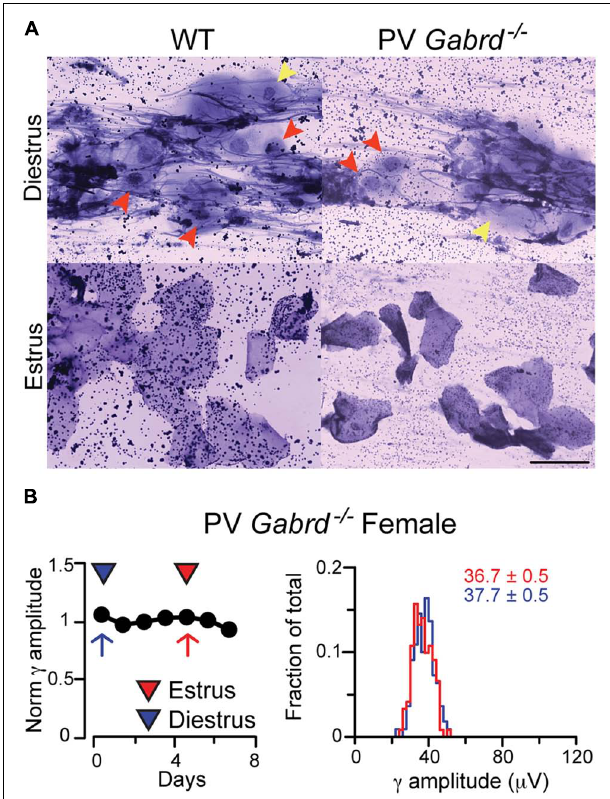
FIGURE 5 | Female PV- Gabrd − / − mice cycle regularly but lack ovarian cycle-dependent modulation of REM phase γ oscillation amplitudes. (A) Ovarian cycle stage was determined by vaginal impedance measurements and cytological analysis of vaginal smears. PV- Gabrd − / − mice had a similar cytological panel toWT mice at different stages. Diestrus was determined by the presence in the smear of abundant mucus, small parabasal cells (red arrowheads) and large intermediate cells (yellow arrowheads). Both cell types are absent in estrus, when smears are typically characterized by large polygonal superficial cells, mostly fully cornified. Scale bar 5 μ m. (B) Left: diagram showing normalized γ amplitudes during REM sleep on consecutive days in a regularly cycling PV- Gabrd − / − female. Red and blue triangles indicate estrus and diestrus, respectively. Right : distribution of γ amplitudes (binned at 2 μ V) recorded during all REM sleep episodes for an entire day of estrus (red) and one of diestrus (blue).The 2 days are marked on the left with red (estrus) and blue (diestrus) arrows. Colored numbers indicate mean ± SEM of the corresponding histograms. Note the narrow variance of the γ amplitude distributions during both phases of the ovarian